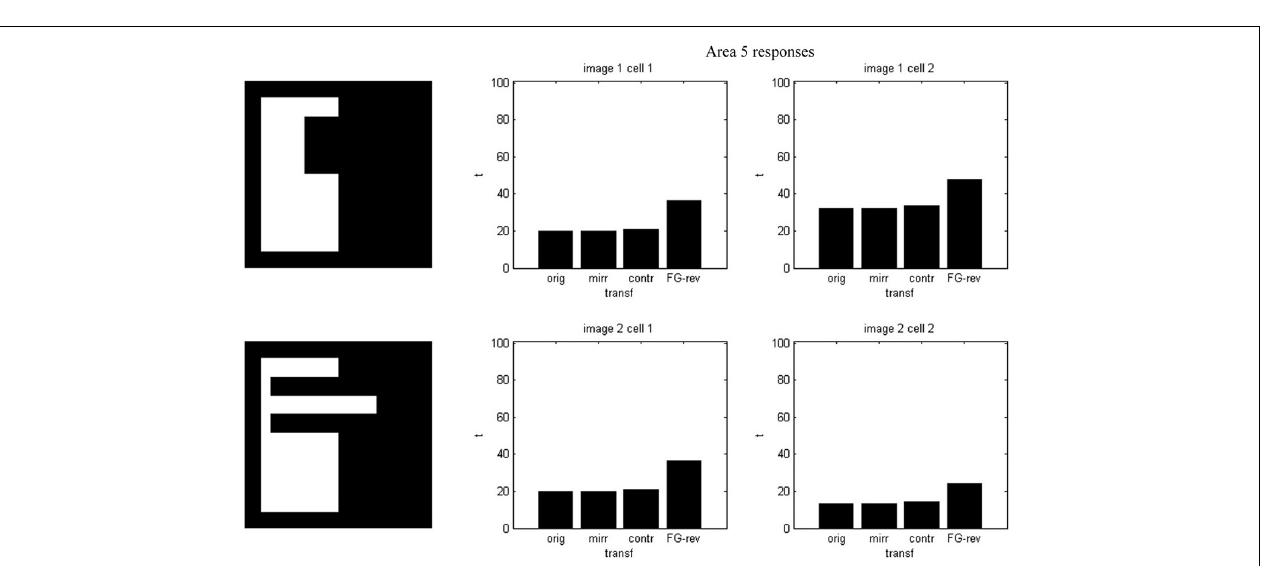
FIGURE 5 | Firing onset times—i.e., first spike times—for the example of Figure 2. Each plot is associated with an image set and an area 5 cell. In every set the spiking starts later when FG-reversal is